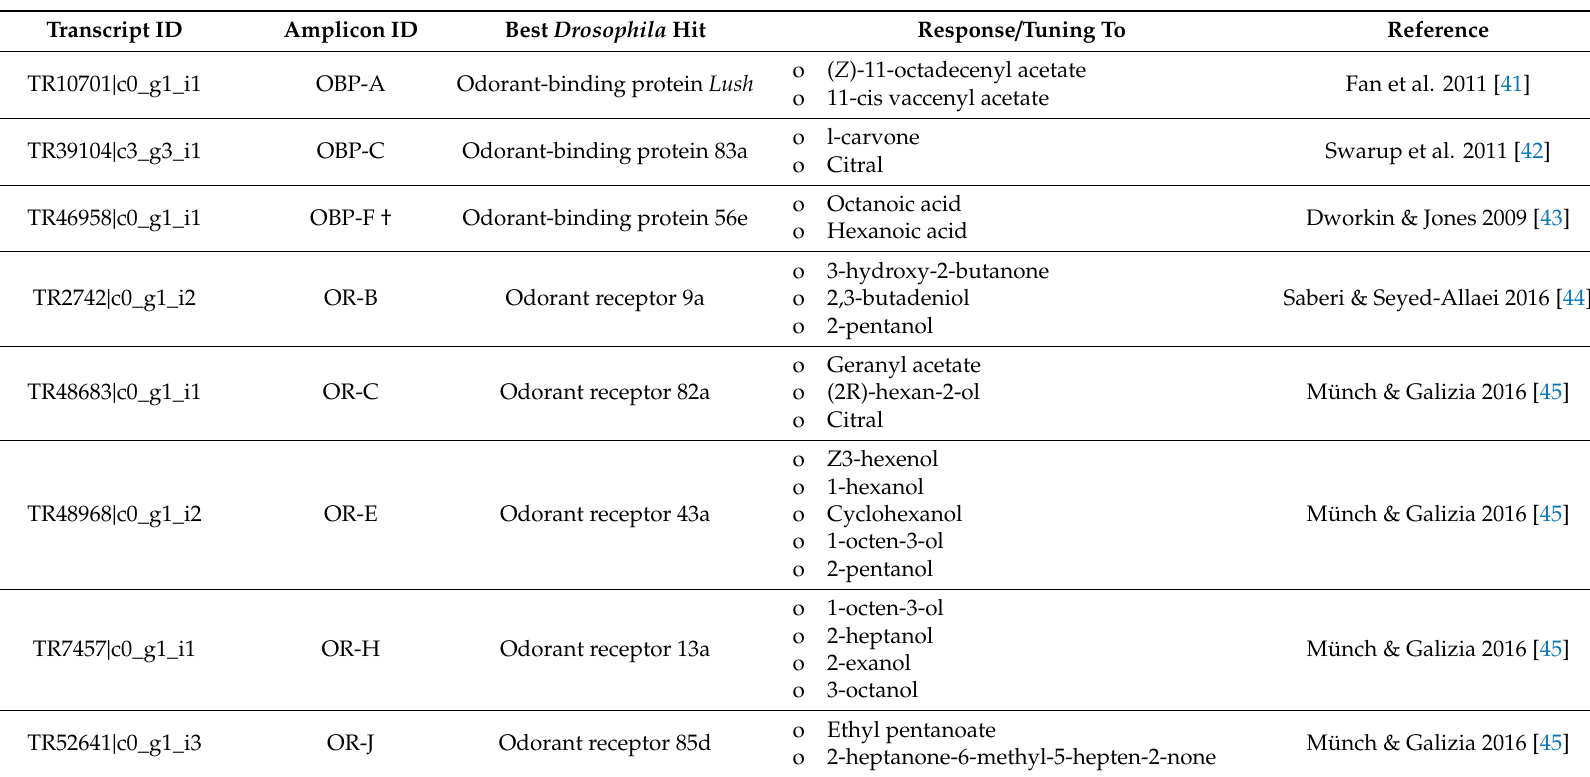
Table 3. Odorant receptor and odorant-binding protein homologs from Drosophila spp. found in A. ervi using BLAST. The odorants eliciting the responses are